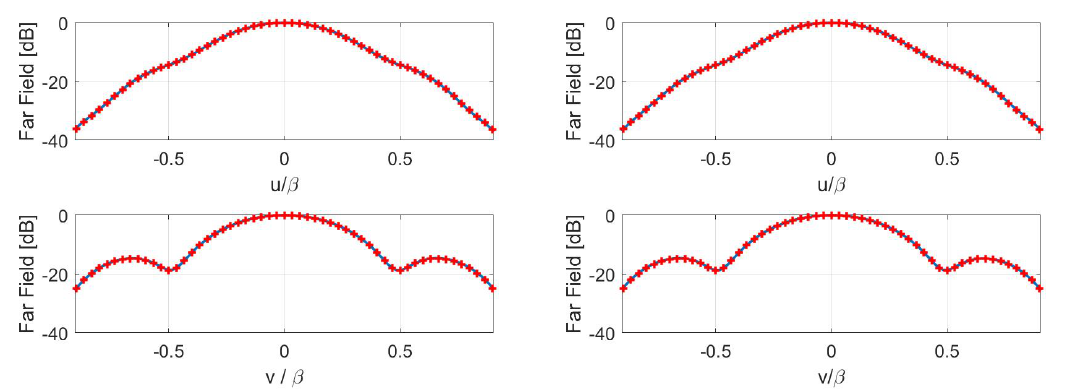
Figure 7. Case A—Cuts, along the u and v planes, of the reference (red pluses) and retrieved (blue solid line) FFP. ( Left ) Shannon number. ( Right ) mutual information.